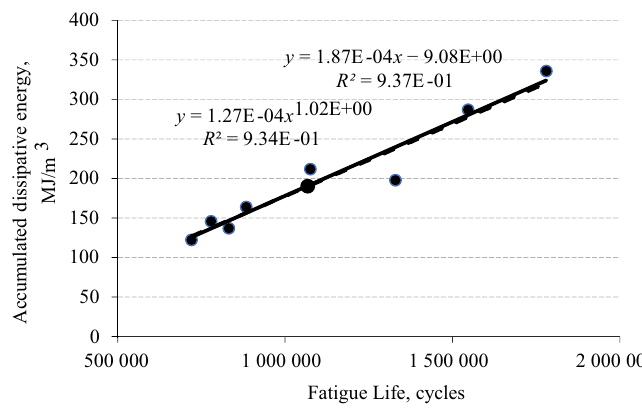
Figure 8. Relationship between fatigue life and accumulated dissipative